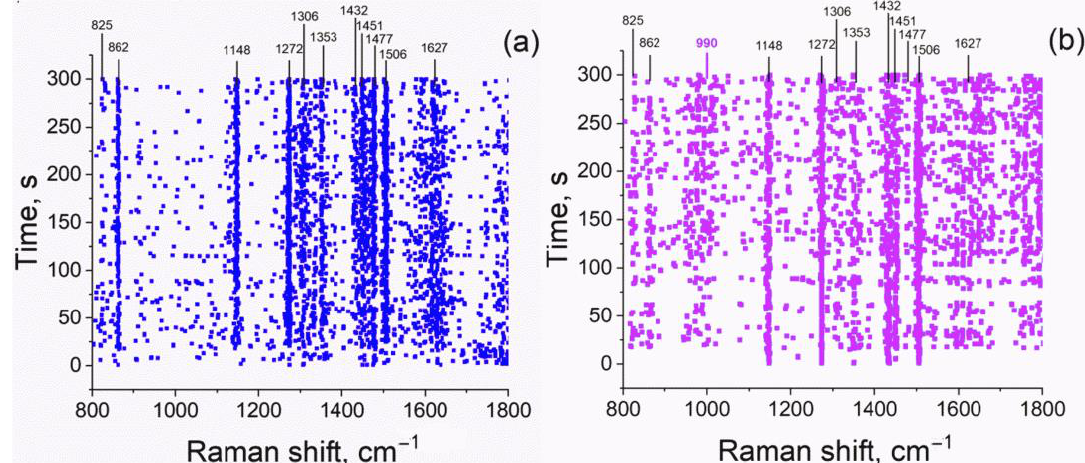
Figure 3. Raman peaks positions maps for ( a ) Ala and ( b ) Ser bound to SNF in PBS. Each point on the map corresponds to a feasible peak in the respective spectrum, as detected by the local maximum method [22].